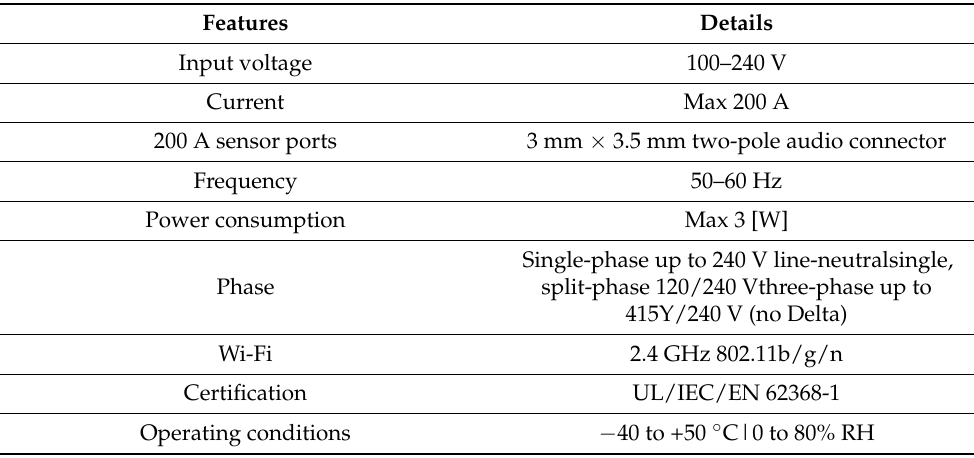
Table 4. Features of the Gen 2 Vue Energy Monitor with current sensors [37].